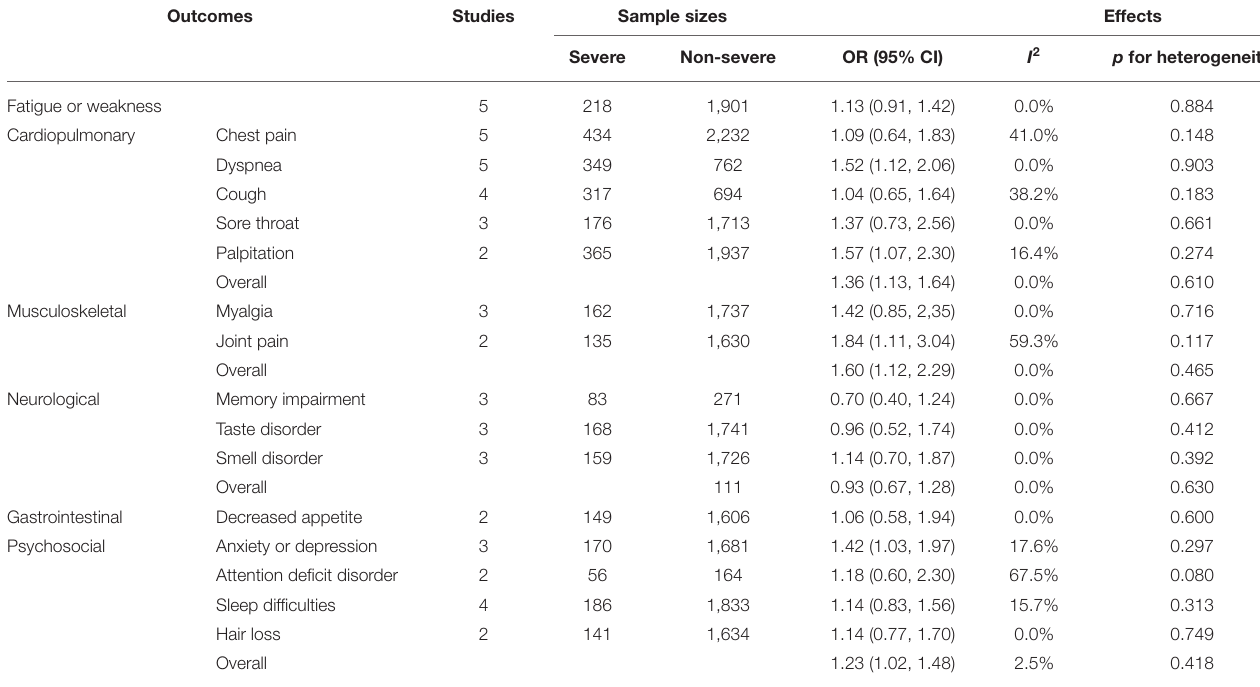
TABLE 3 | The pooled OR of symptoms and manifestations in multiple systems between severe and non-severe patients. Outcomes Studies Sample